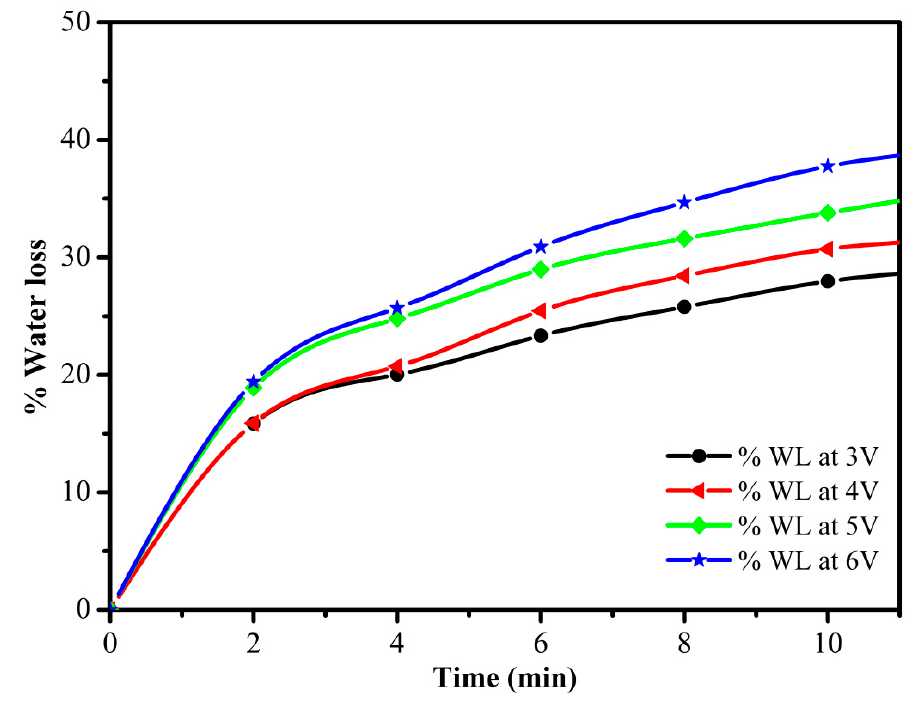
Figure 5. Water loss of the SPVC–PTA–Pt IPMC membrane at 3–6 V DC.